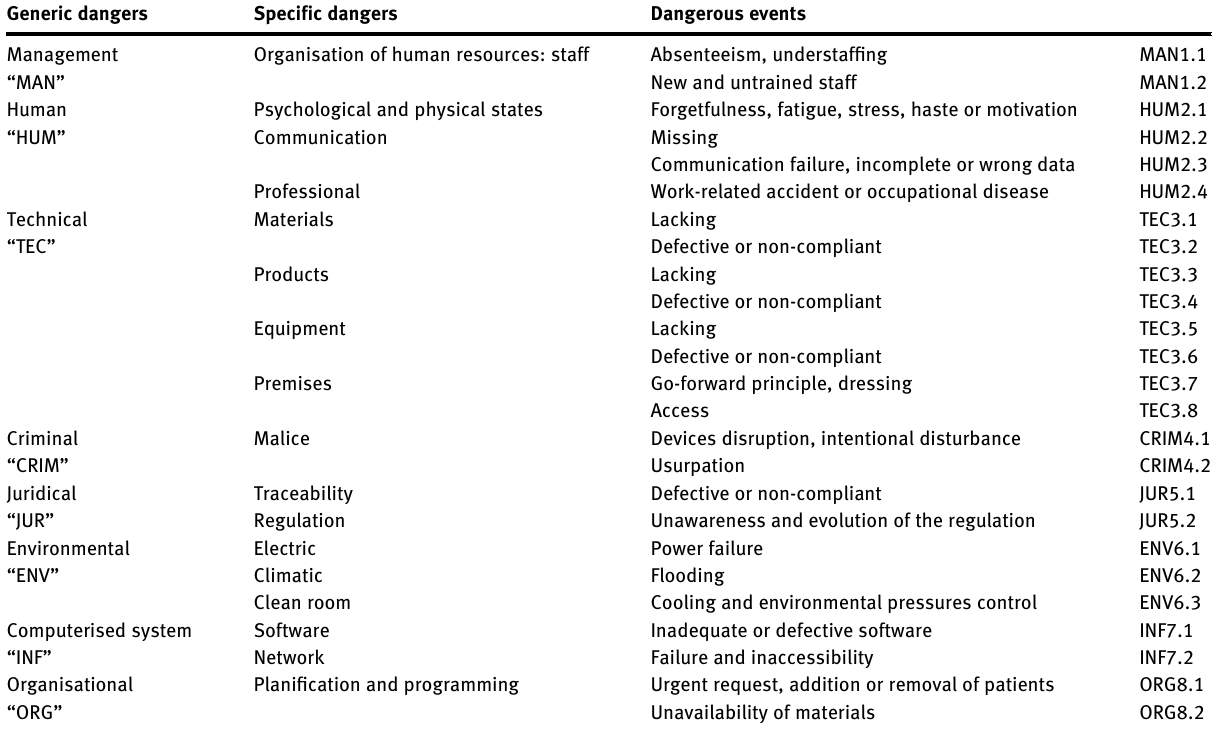
Table  : Dangers mapping. Generic